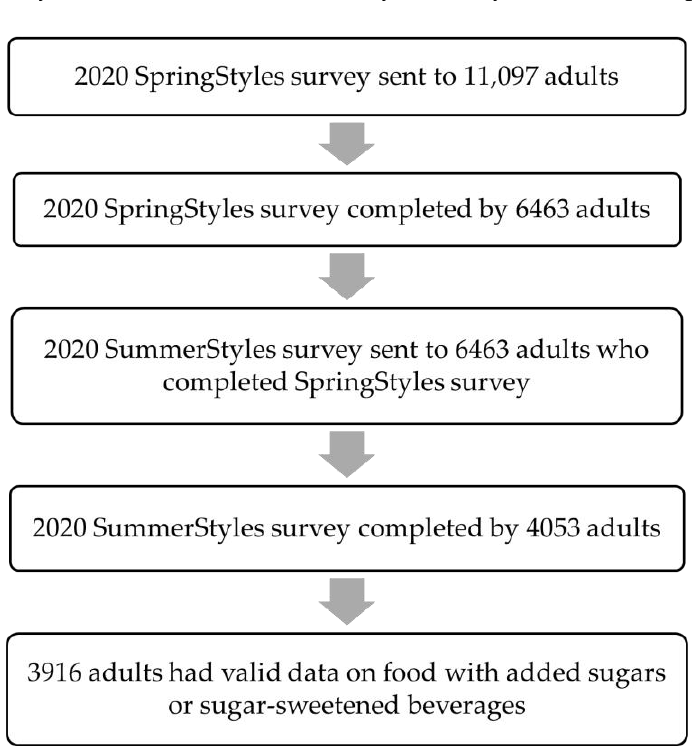
Figure 1. Analytic sample flow chart for SummerStyles survey, 2020.